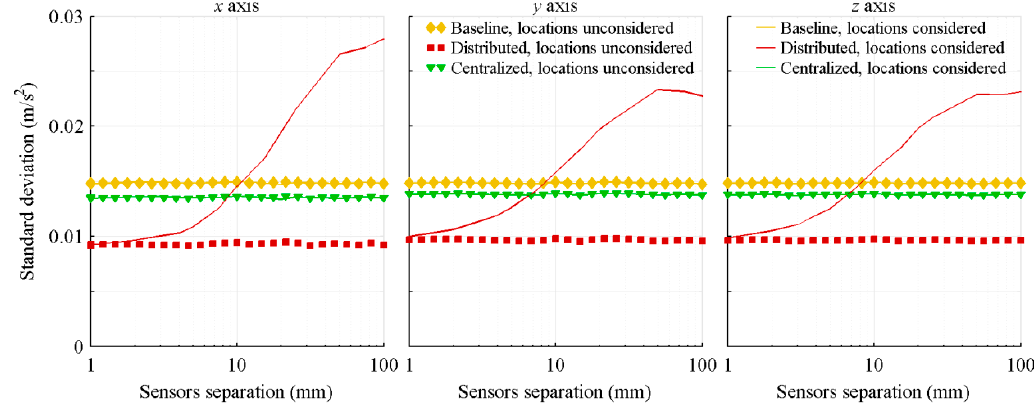
Figure 2. Standard deviation of the acceleration estimation errors, with respect to the distance between the IMUs. Sensors 2018 , 18 , x FOR PEER REVIEW